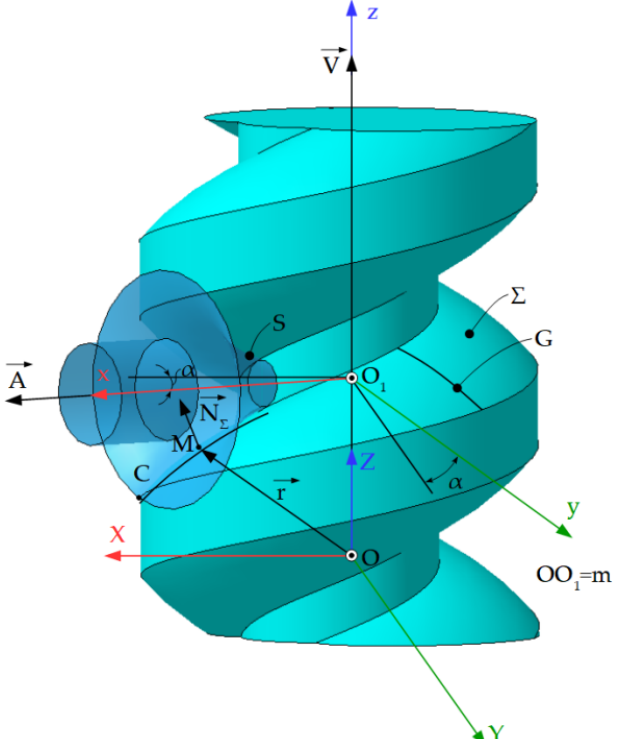
Figure 16. Generating of the helical surface with the finger cutter tool, reference systems: XYZ represents the mobile coordinate system, solid with the surface Σ , xyz —fixed reference system, → having the x -axis superimposed on the tool axis, A.